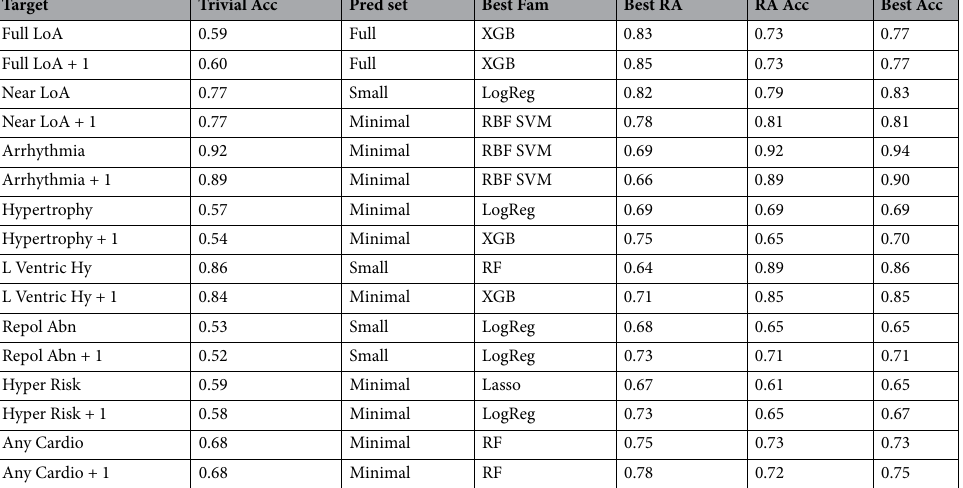
Table 3. Predictions of categorical data. The table shows the best performing models for each categorical target. Targets marked with + 1 are the results for the next visit only. The best ROC-AUC score is the overall best result of all models, the RA accuracy is the accuracy achieved from that model, thus not necessarily the overall best accuracy reached. The best overall accuracy is given in the best accuracy column. The trivial predictor for categorical targets was predicting the most common category for all data points. Acc Accuracy; RA ROC-AUC score; Pred Set predictor set; Best Fam model family reaching the best result; XGB extreme gradient boosting; RBF SVM support vector machines with radial basis function; RF random forest; LogReg logistic regression; LoA Loss of Ambulation; L Ventric Hy left ventricular hypertrophy; Repol Abn repolarisation abnormalities; Hyper Risk engineered variable coding the likelihood of the presence of cardiac hypertrophy.